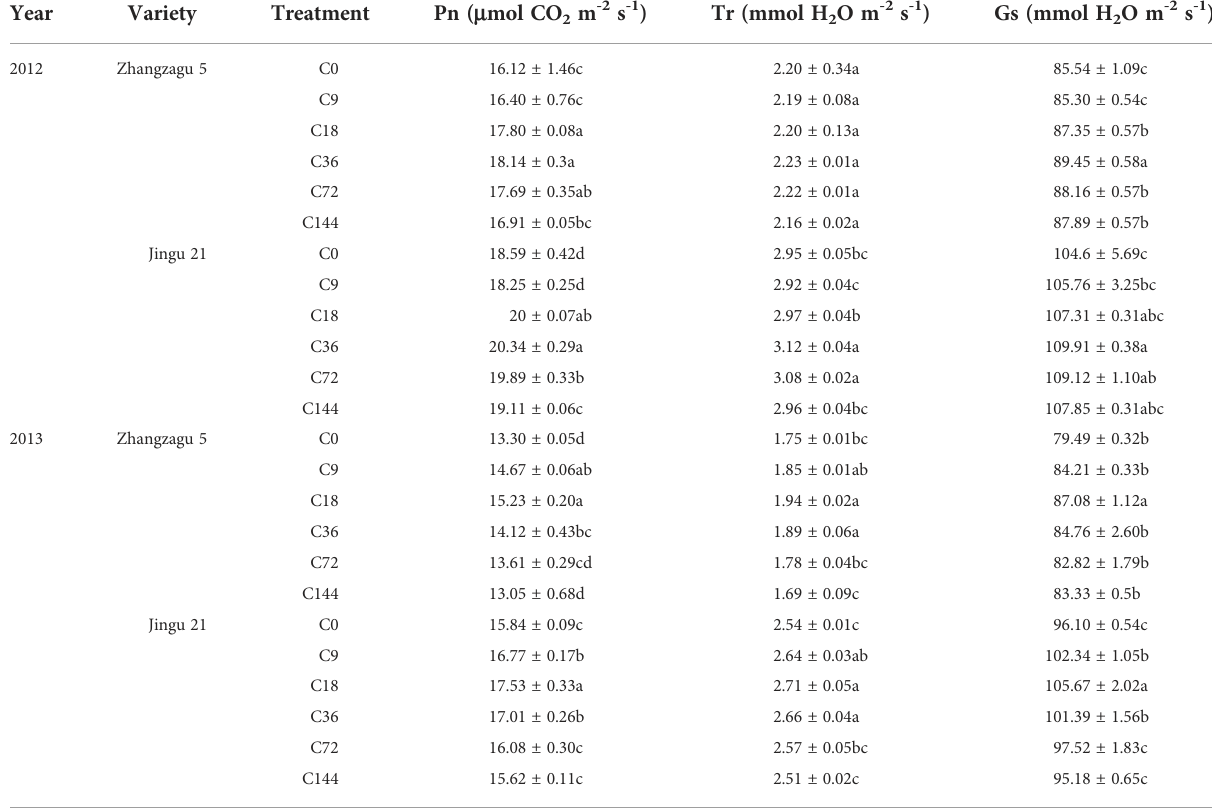
TABLE 2 Effects of naphthalene acetic acid on gas exchange parameters in leaves of foxtail